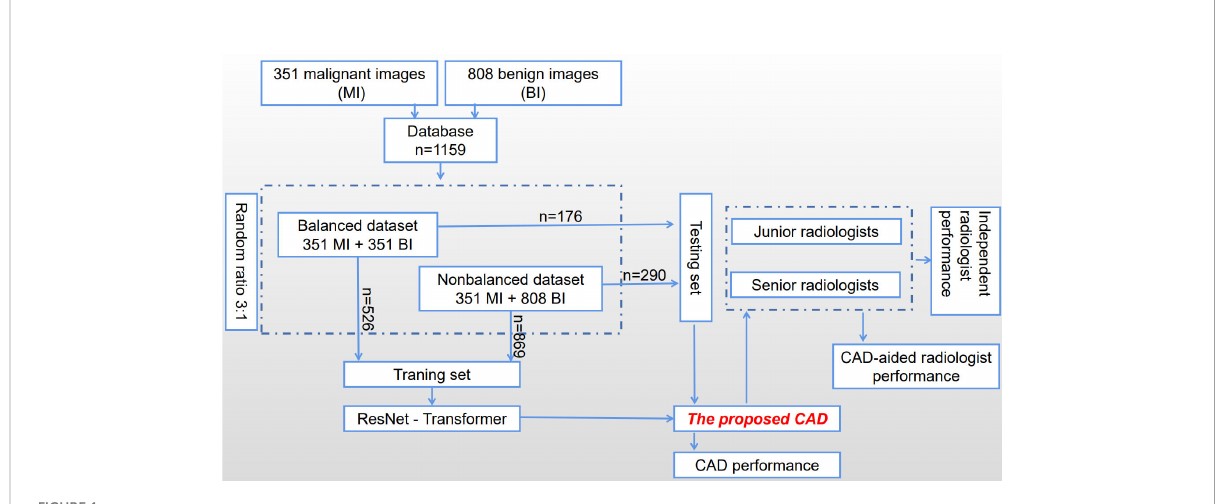
FIGURE 1 Flowchart of the construction and validation of the proposed